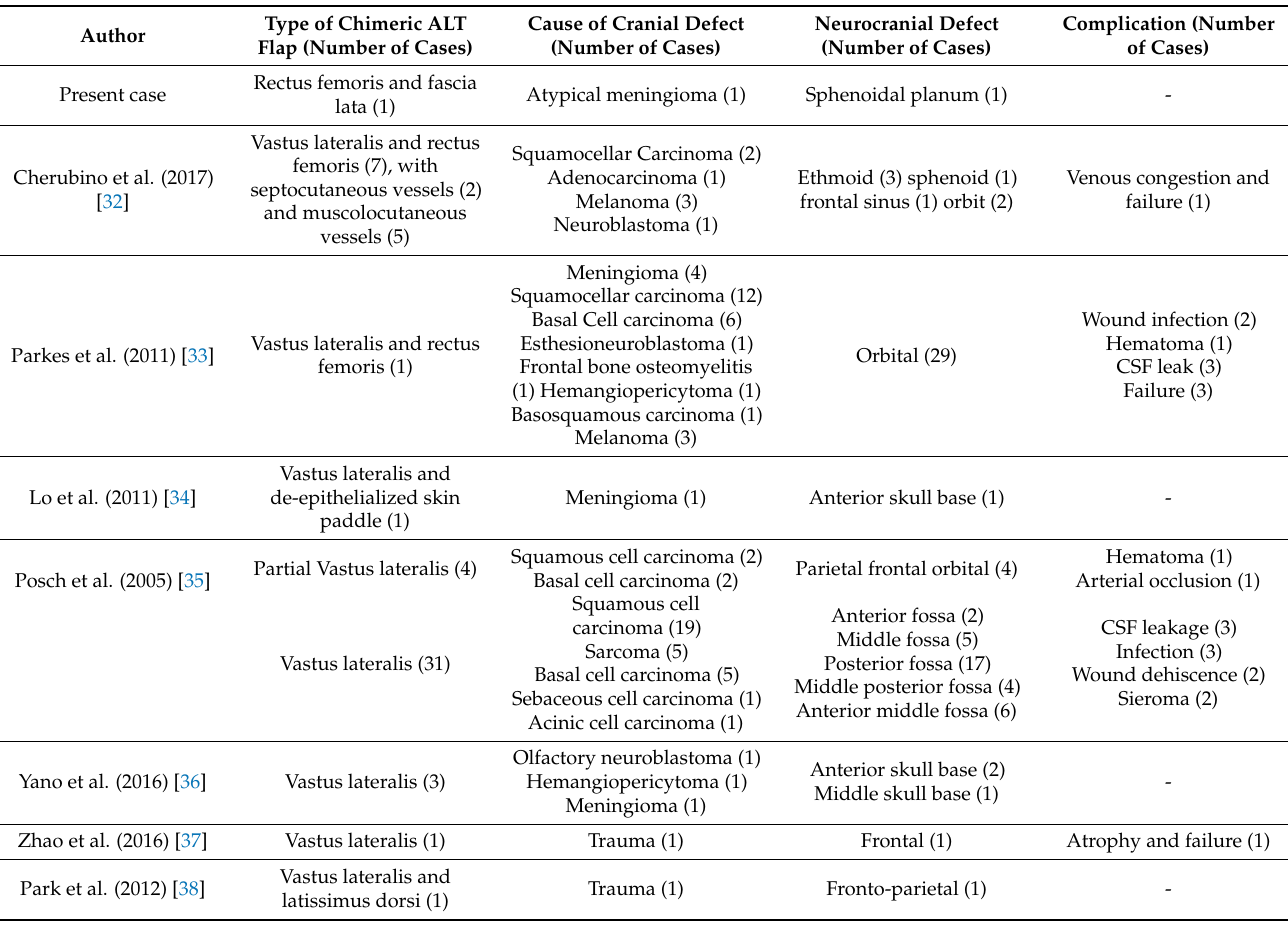
Table 1. Literature review of chimeric ALT free flap in neurosurgical